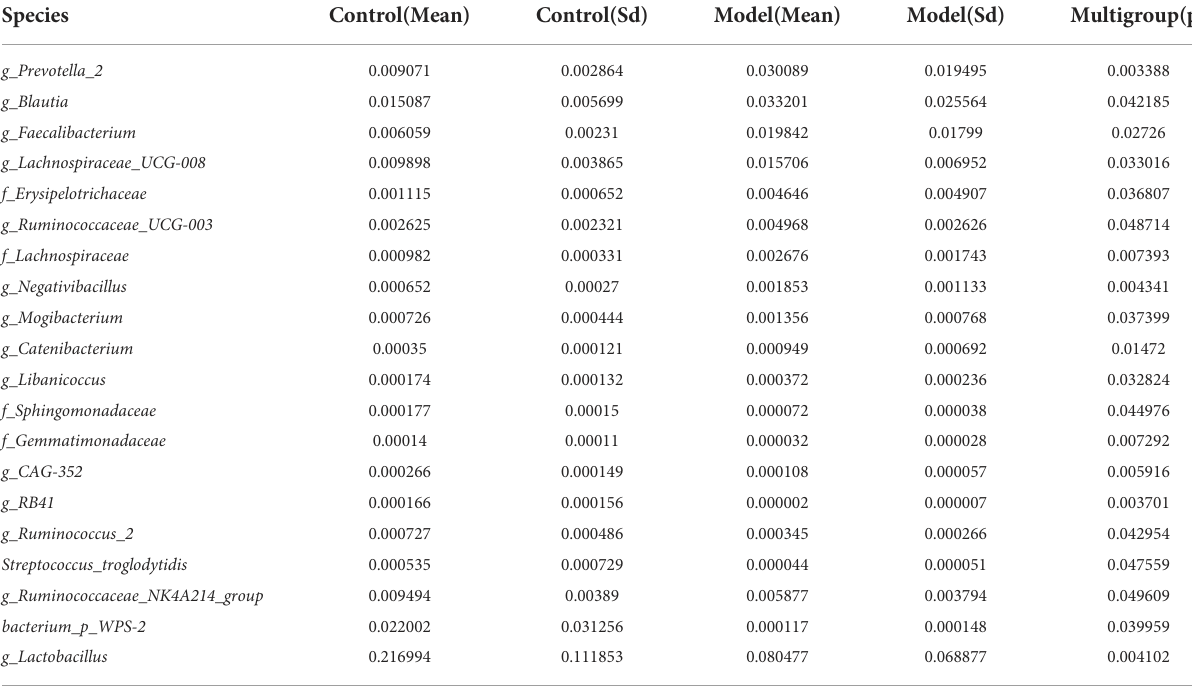
TABLE 6 ANOVA (Analysis of Variance) at species level of bacterial microbiota of Cynomolgus macaques ( p <0.05).